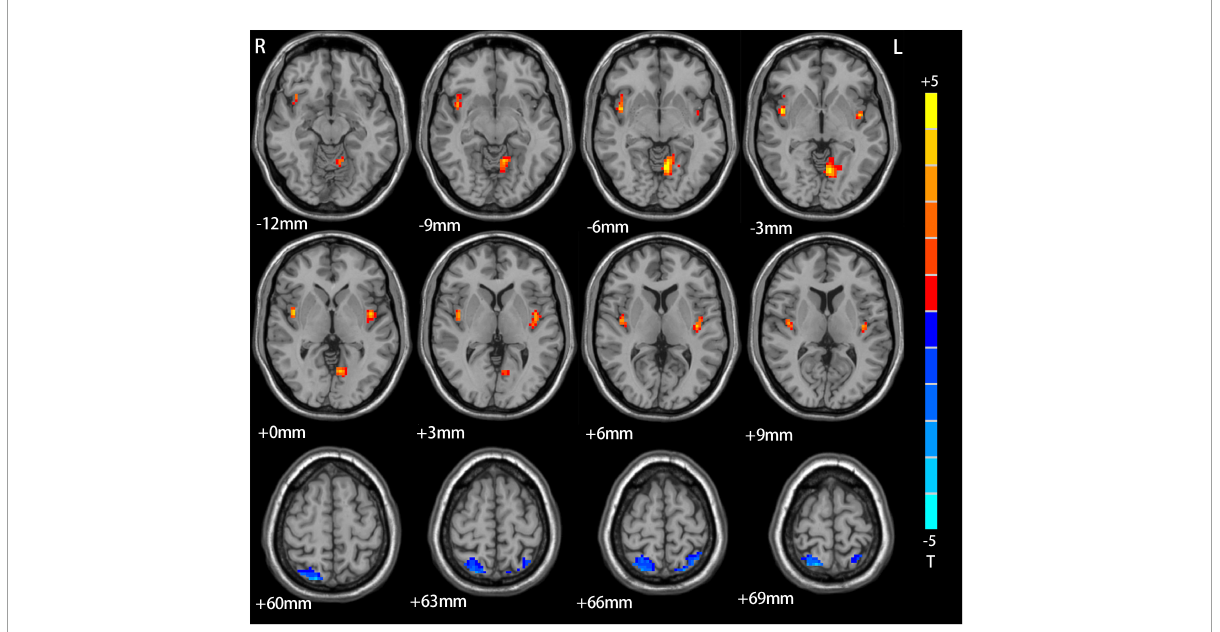
FIGURE1 The difference between adolescents depression patients and HCs. Red means increase of DC value, blue means decrease of DC value.